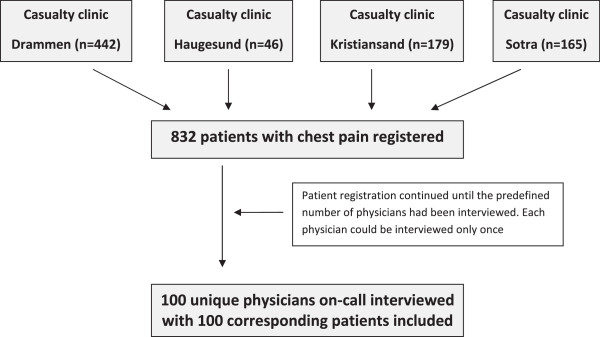
Flow chart of registration of patients and the inclusion process.